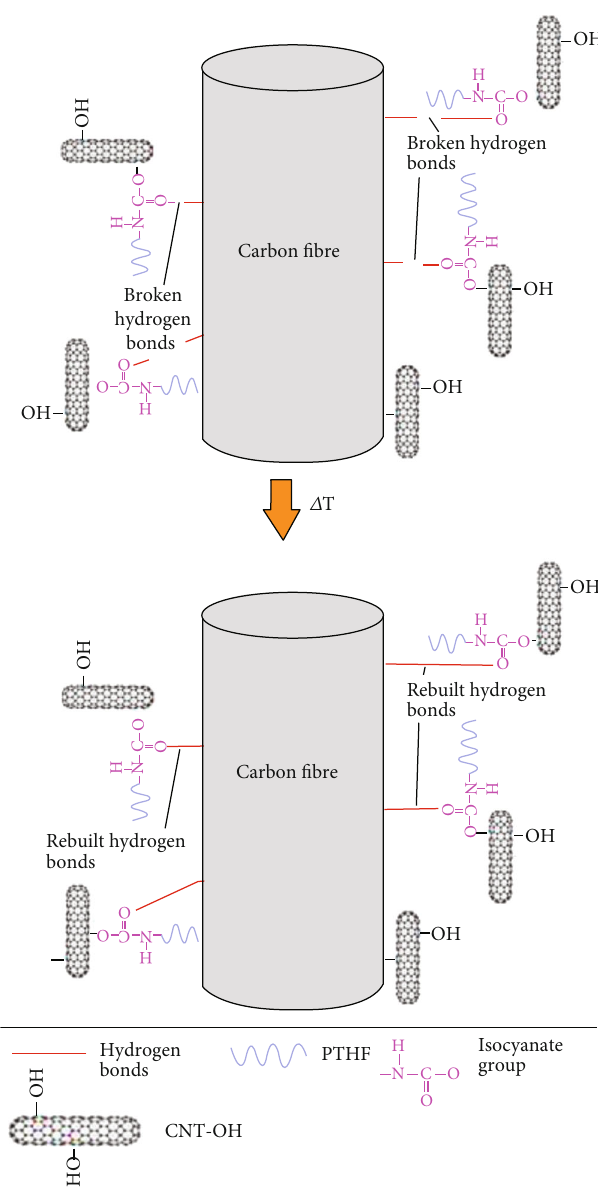
Figure 10: Scheme of healing mechanism in the PU matrix containing CNT-OH and